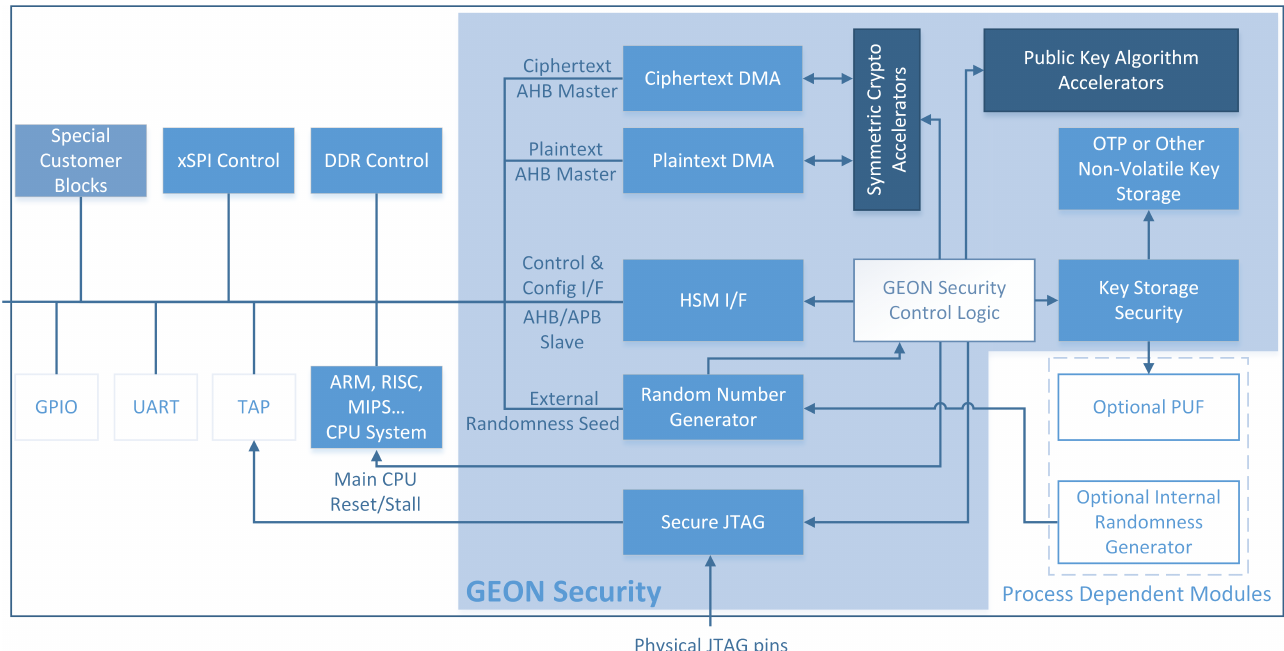
Figure 6. GEON SoC Security Platform hardware architecture, based on [65]. External interfaces and suggested connections to other components of System on Chip are